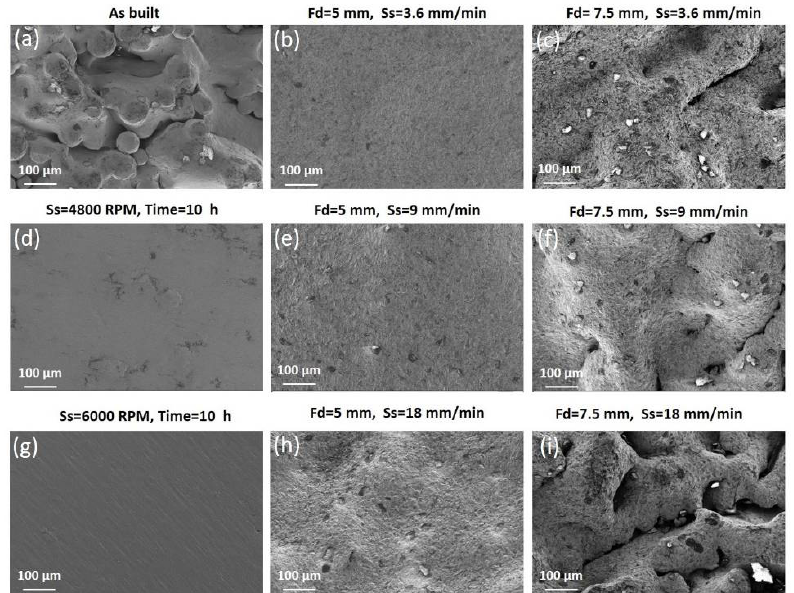
Figure 5. SEM analysis of the external surfaces of the as-built sample and treated ones: ( a ) As-built sample; ( b ) Laser finished sample (Fd = 5 mm, Ss = 3.6 mm/min); ( c ) Laser finished sample (Fd = 7.5 mm, Ss = 3.6 mm/min); ( d ) AFB finished sample (Ss = 4800 RPM, time = 10 h); ( e ) Laser finished sample (Fd = 5 mm, Ss = 9 mm/min); ( f ) Laser finished sample (Fd = 7.5 mm, Ss = 9 mm/min); ( g ) AFB finished sample (Ss = 6000 RPM, time = 10 h); ( h ) Laser finished sample (Fd = 5 mm, Ss = 18 mm/min); ( i ) Laser finished sample (Fd = 7.5 mm, Ss = 18 mm/min).